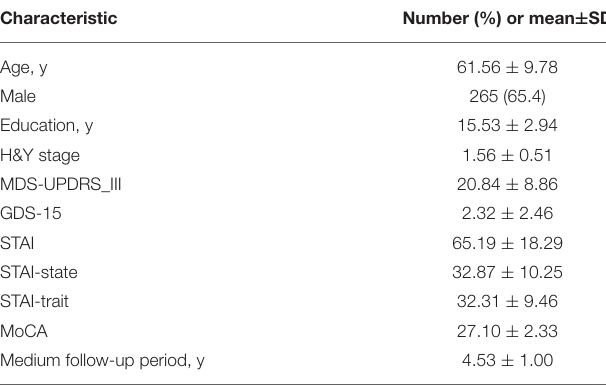
TABLE 1 | Baseline demographic and clinical